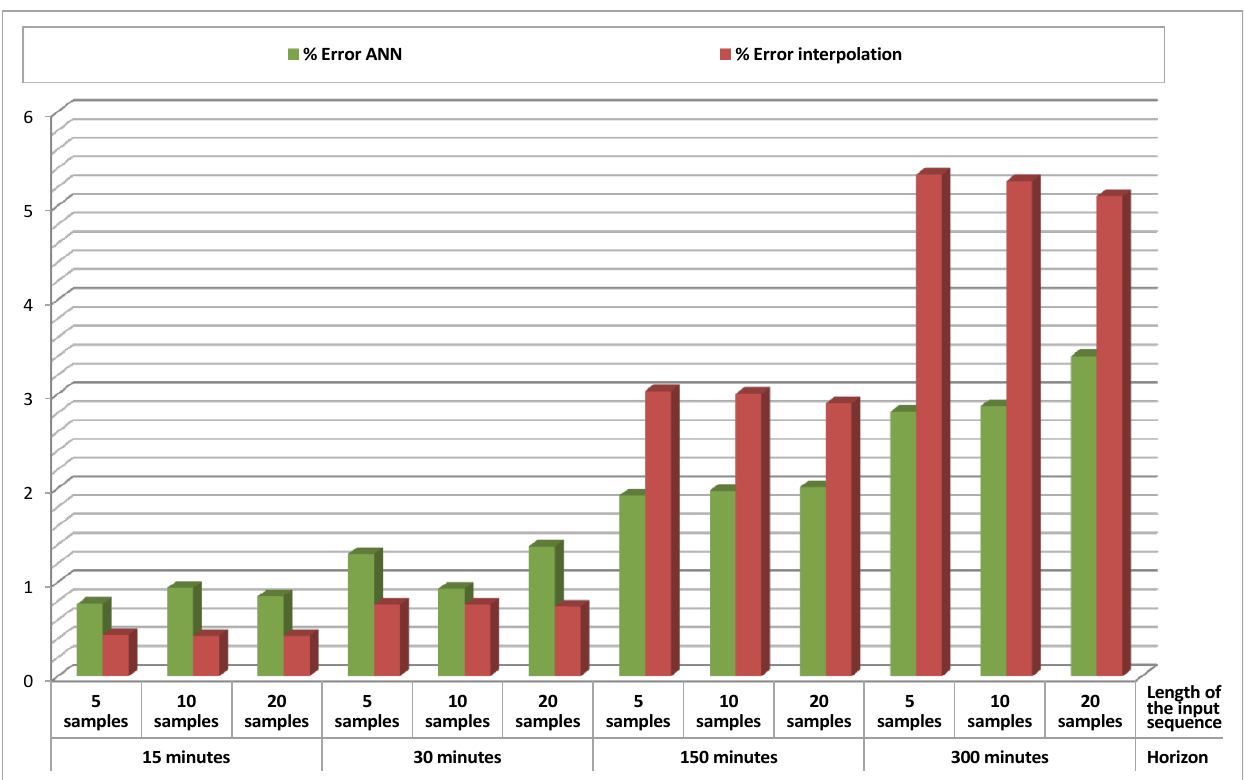
Figure 8. Data prediction results (% error ANN/% error interpolation) for temperature in Sensor 1, using temperature in Sensor 1 as an input.